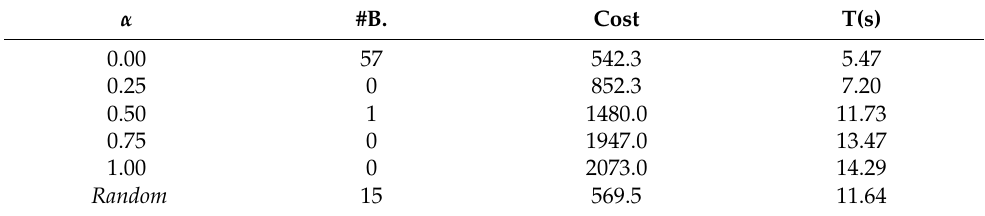
Table 1. Performance of the different values of α for the proposed constructive method after 10,000 iterations.